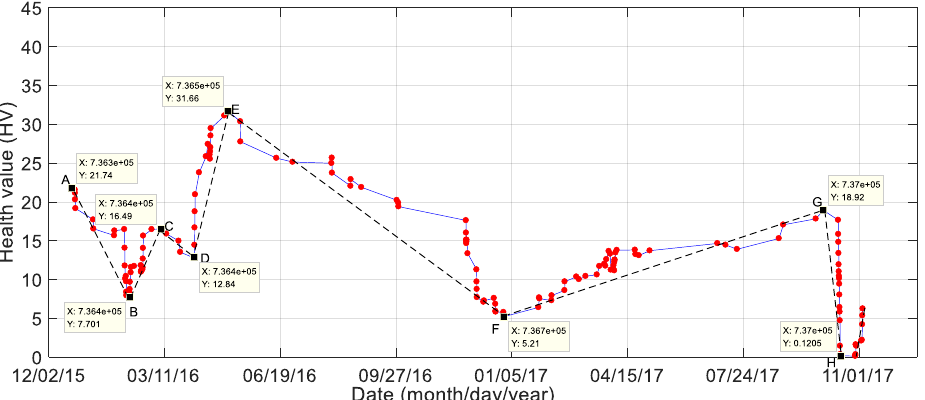
Figure 12. HV curve of T22 wind turbine obtained using the PAM in the RPOR.